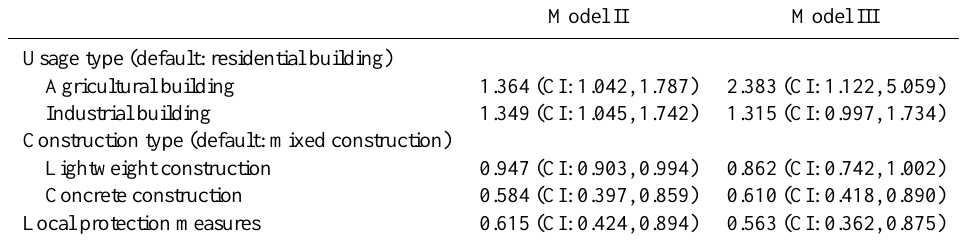
Table 3. Risk ratios for factors characterizing the elements at risk; 95% confidence intervals are reported in